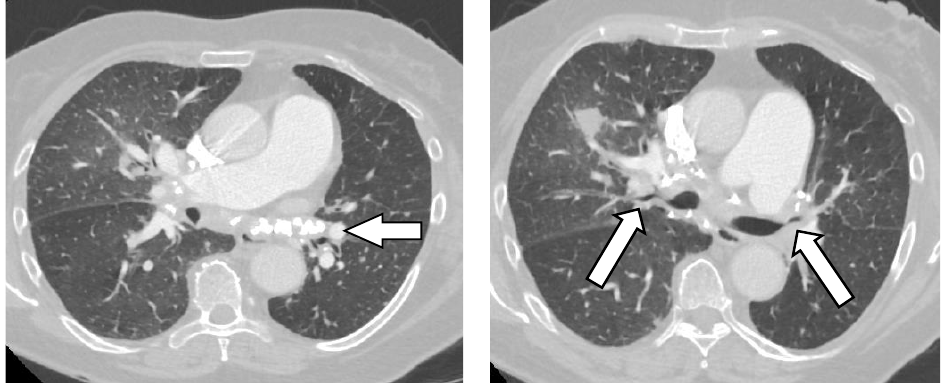
Figure 7. Fibrosing mediastinitis. ( Left image) Arrows points at heavy calcification in the mediastinum. ( Right image) both arrows point at severe stenosis of bronchial lumen.